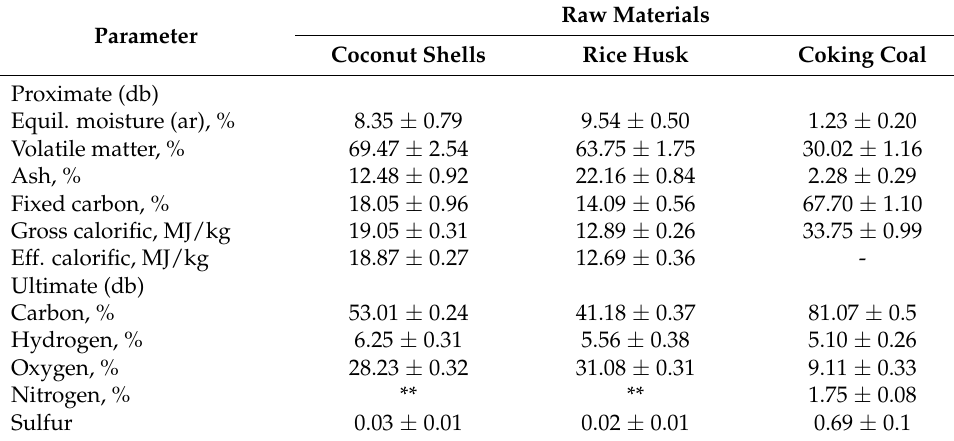
Table 2. Proximate and ultimate analyses of raw